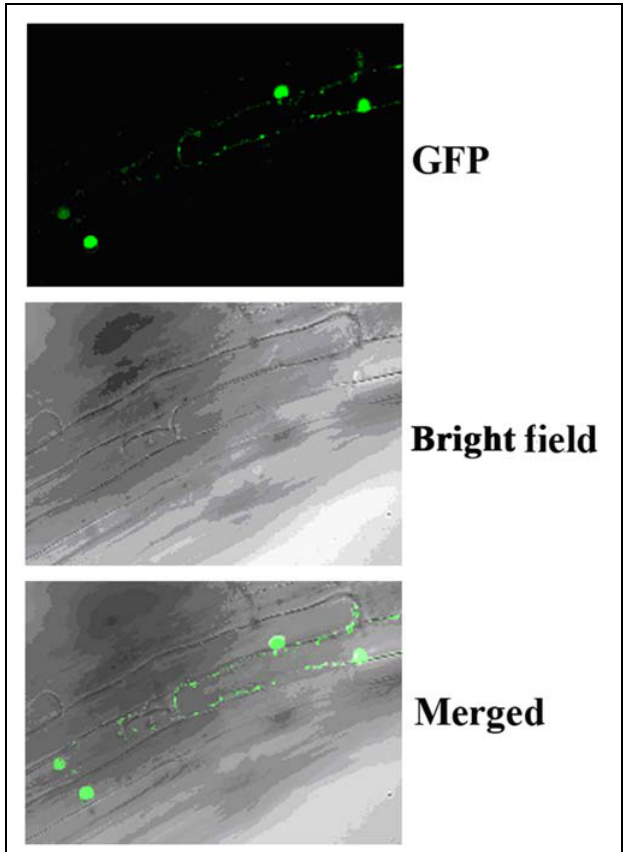
FIGURE 2 | Subcellular localization of OsIAA9. Root tips of transgenic Arabidopsis seedlings expression GFP-OsIAA9 under the control of the 35S promoter were examined under a florescence microscope. (Upper) GFP channel, (middle) bright field image, (lower) merged.